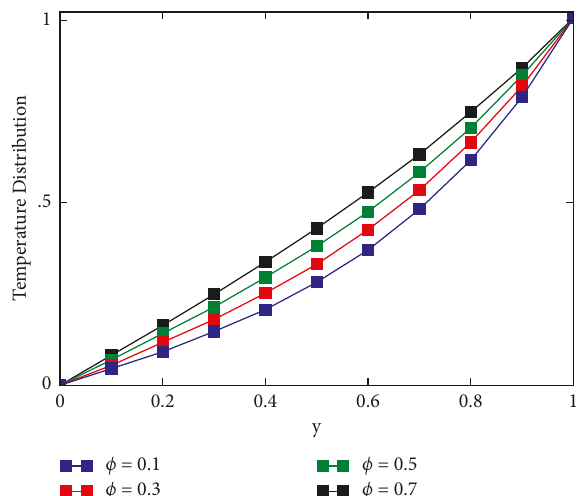
Figure 11: Effect of ϕ